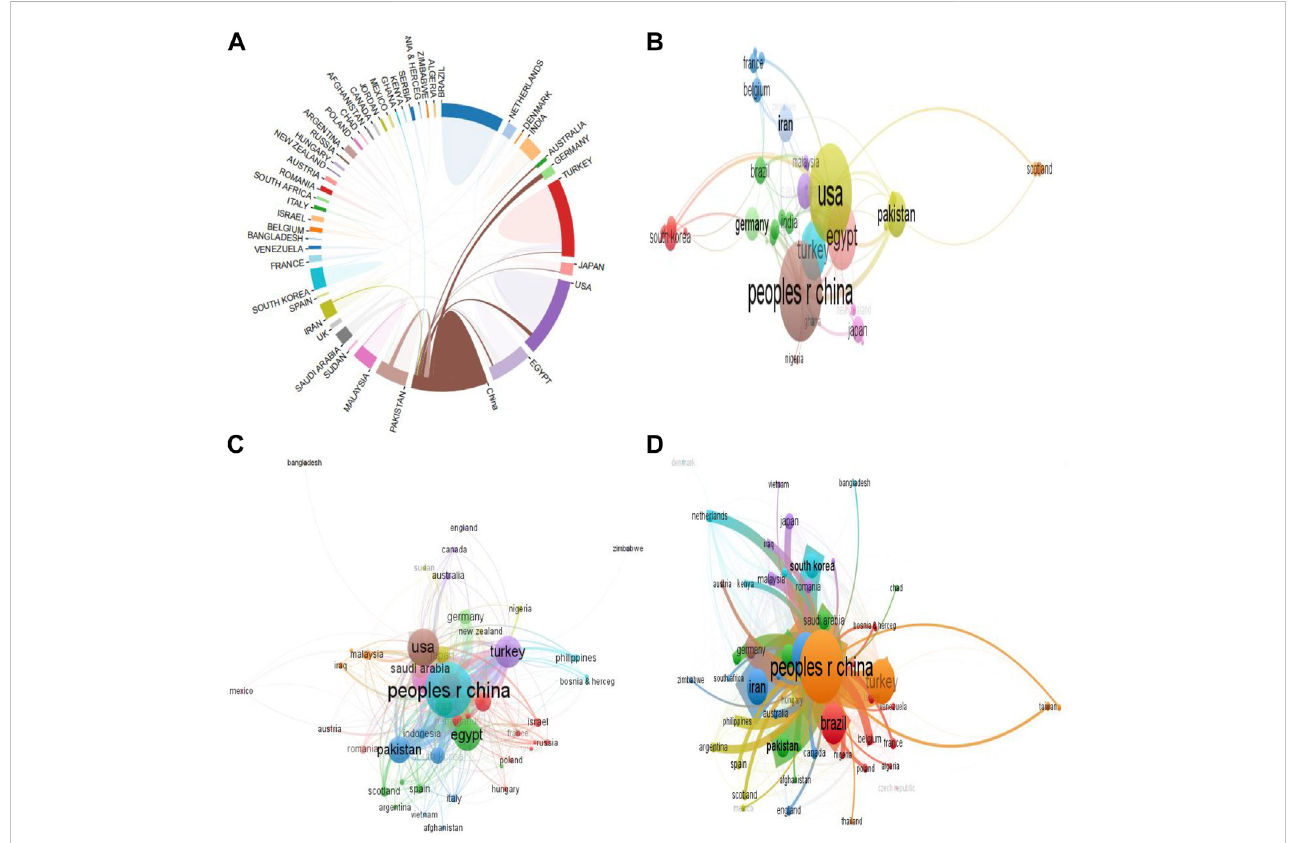
FIGURE 5 Countries contributions to research on heat stress in poultry. (A) Interrelationship between contributing countries. (B) Co-authorship mapping of countries. (C) Citationanalysisofcountries. (D) Bibliographiccouplingofcountries. Thelargerthenode,thegreaterthecountry ’ scontribution,andthethicker the line, the greater the link strength between two connected